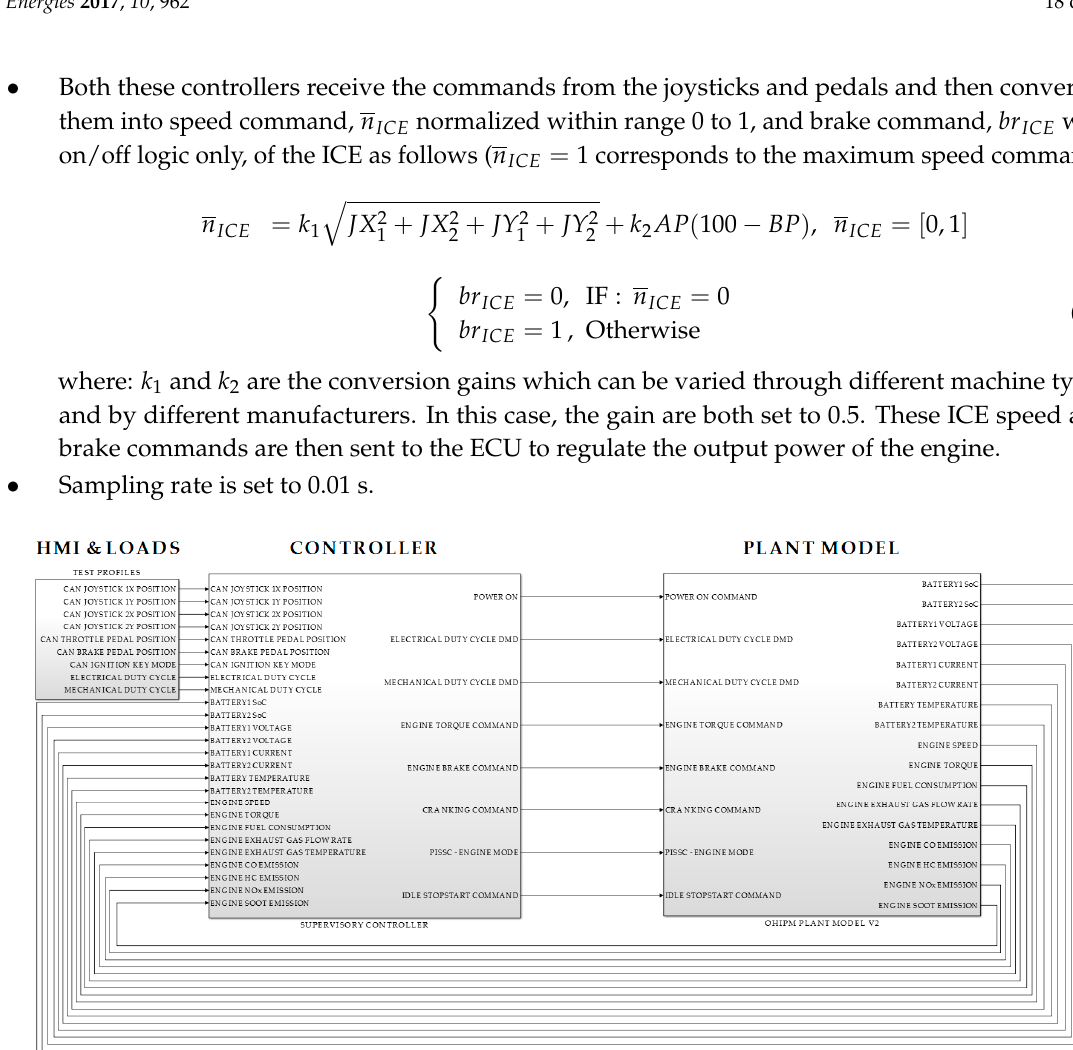
Figure 15. Simulated ICE mode command and speed response using PISSC during the first eight cycles.